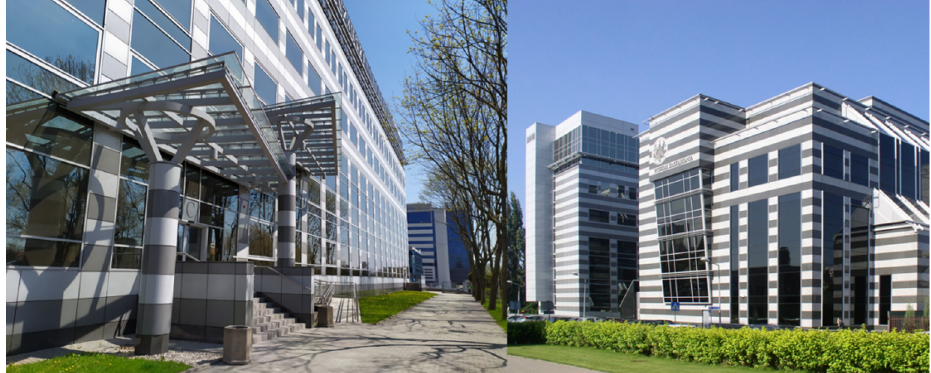
Figure 1 . The campus seen from South-West (left) and North-East (right). Figure 1. The campus seen from South-West (left) and North-East (right). The adopted research objective pertained to determining whether it is possible, after providing incentives, to change occupants’ behavior, leading to a reduced thermostat set- ting of the proposed value. Taking all the considerations into account, the ESO experiment was designed, as graphically presented in Scheme